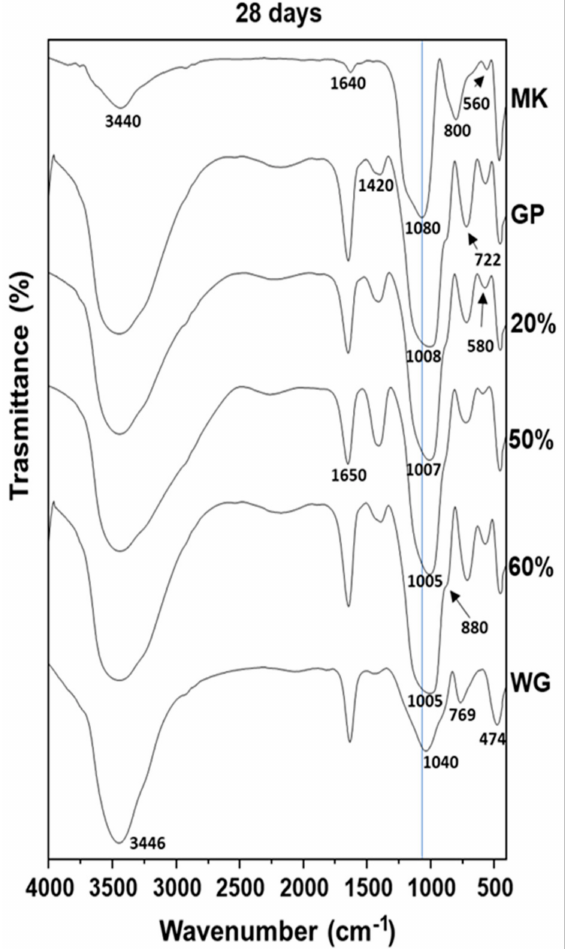
Figure 6. FT-IR comparison spectra of MK, WG, GP and GP/WG samples extracted after 28 days of curing time. The percentages indicate the waste glass